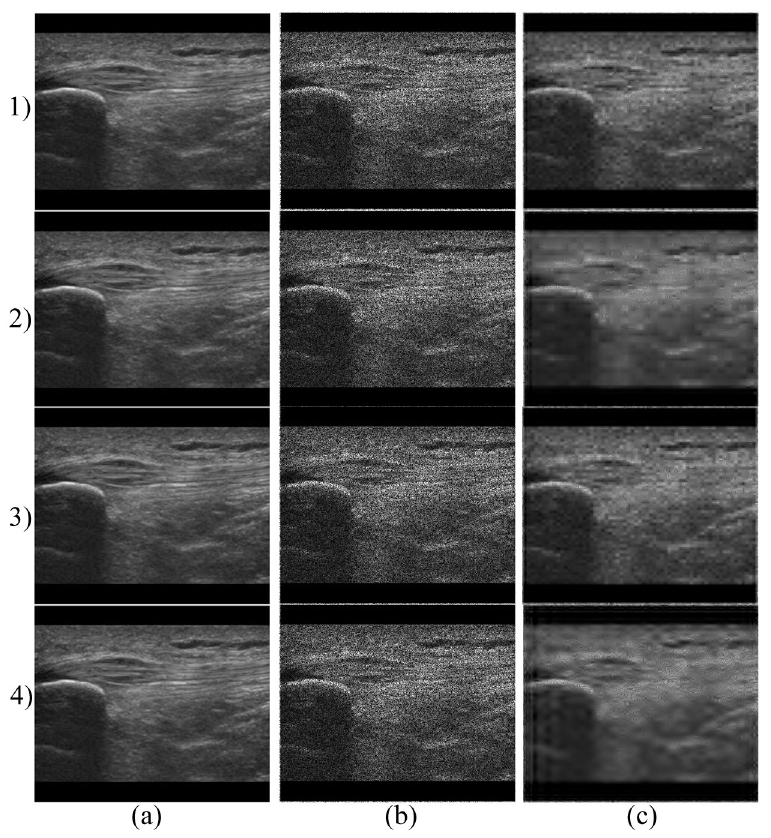
Fig 12. An example of denoising results on MSK image dataset using the selected wavelets. 1) Denoising using the Db2 , level of decomposition 3. a) native image, b) noisy image (speckle noise ( μ = 0, σ 2 = 1)) and c) result of noise- canceling procedure; Denoising using the Db2 , level of decomposition 4. a) native image, b) noisy image (speckle noise ( μ = 0, σ 2 = 1)) and c) filtration result; Denoising using the Sym2 , level of decomposition 3 (3) and Sym29 with level of decomposition 4 (4). a) native image, b) noisy image (speckle noise ( μ = 0, σ 2 = 1)) and c) filtered MSK image.